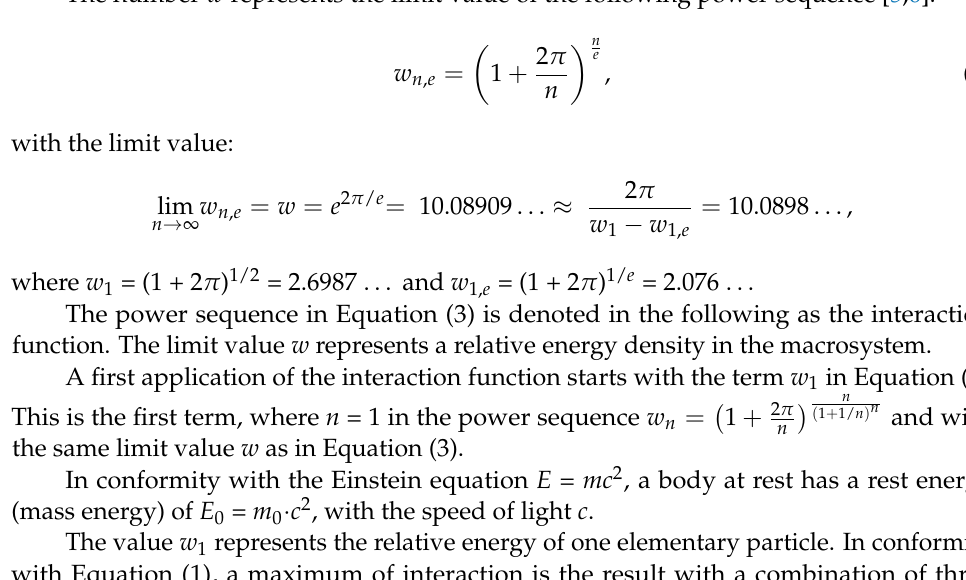
Figure 1. Graph of the function y = x 2 π /x